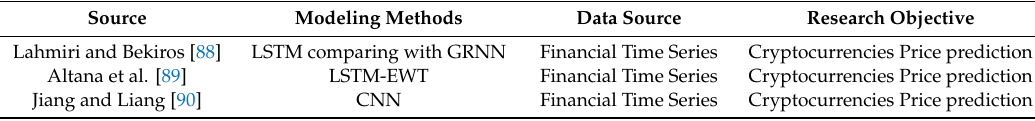
Table 6. Notable machine learning and deep learning methods in Cryptocurrency.